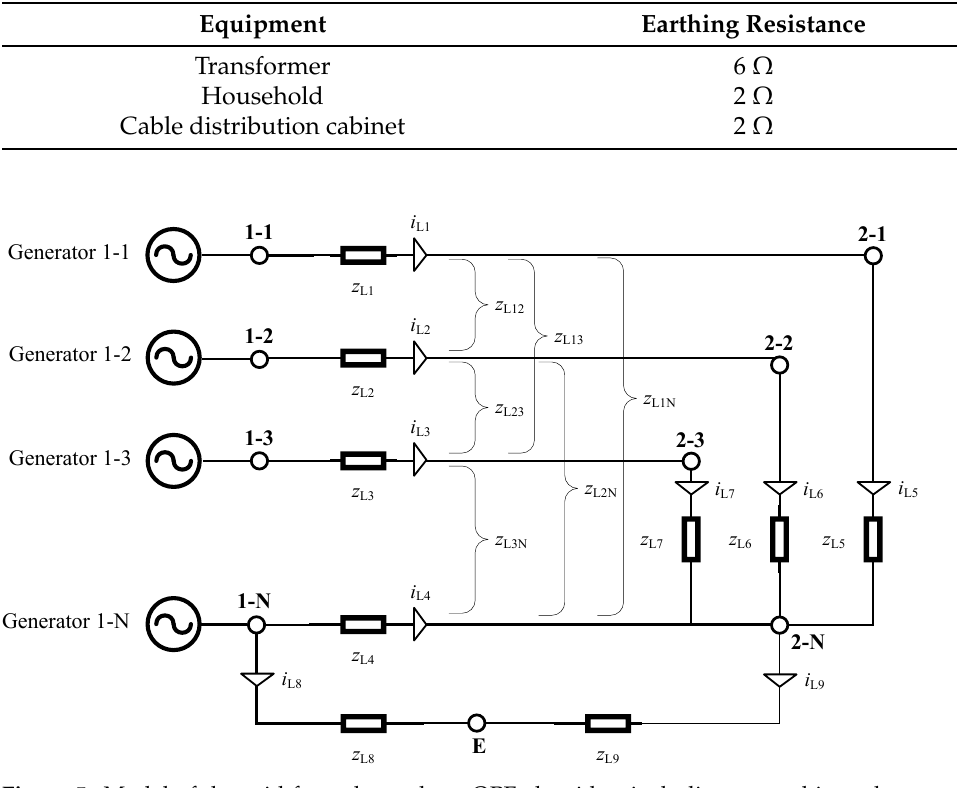
Figure 5. Model of the grid for a three-phase OPF algorithm including mutual impedances and earthing